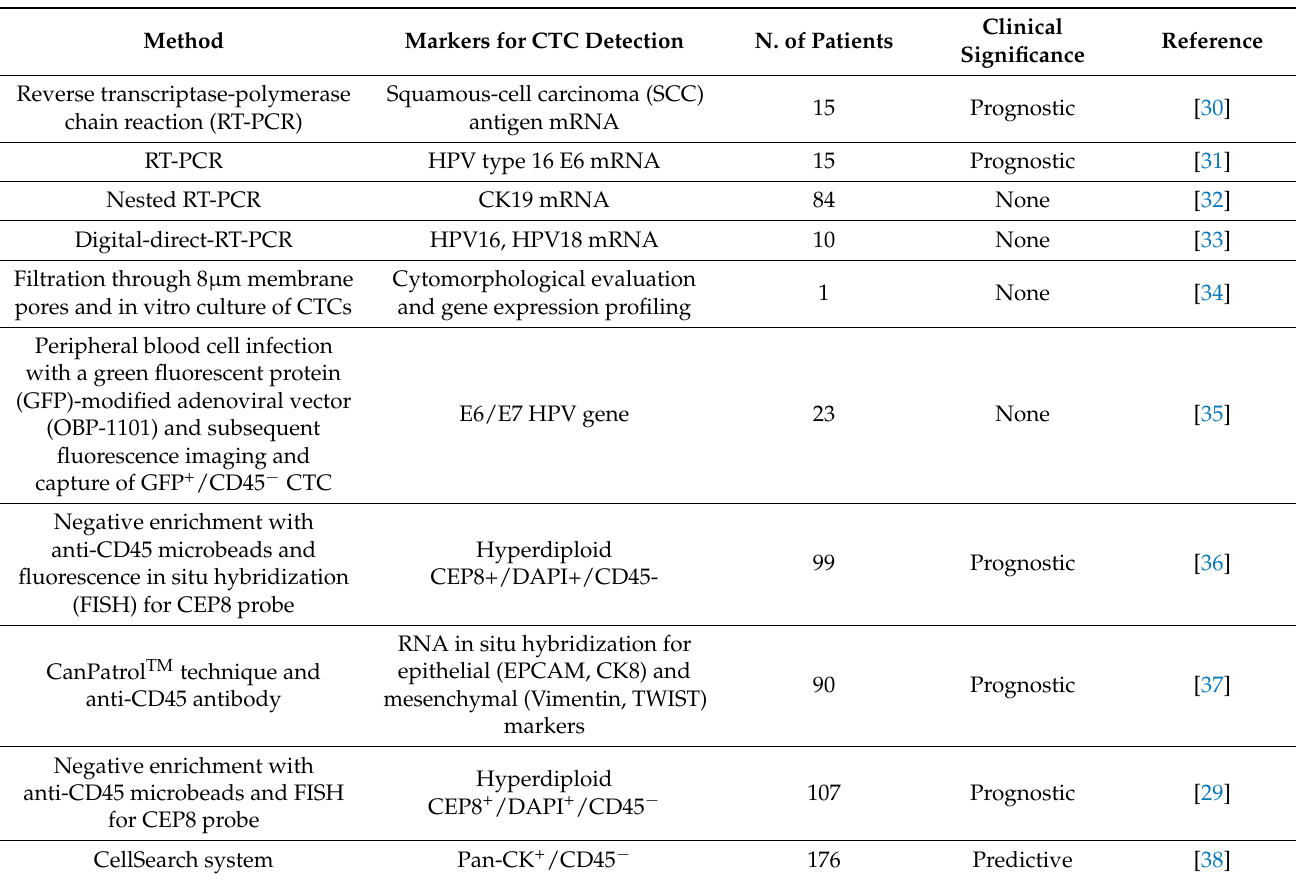
Table 1. Summary of methods used to identify CTCs in